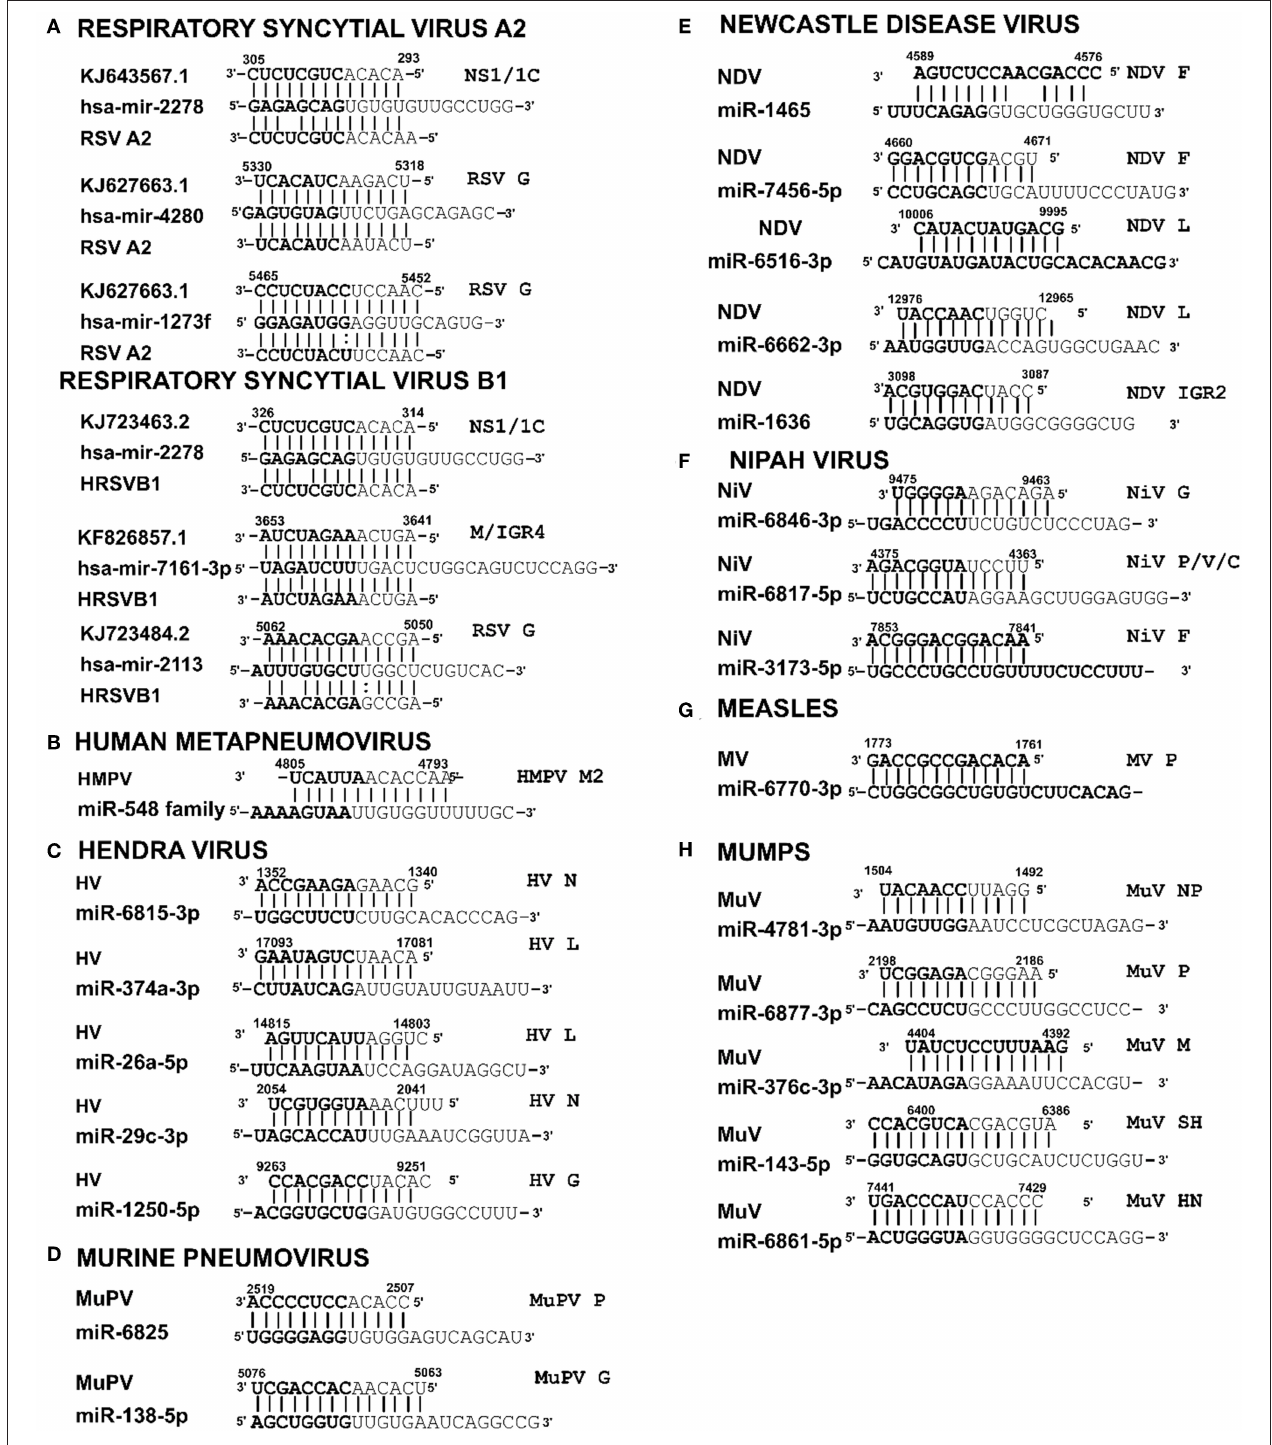
FIGURE 3 | Sequence alignments of miRNA vSSs encoded by different paramyxoviruses. Alignments show complementarity between host miRNA seed site and the corresponding vSS across Paramyxoviruses . Nucleotide numbers indicated viral genome coordinates while labels on the right indicate encoding viral gene. miRNA seed sequence is indicated in bold. Straight lines indicate Watson-Crick base pairing (AU/GC) while colon indicates a non-Watson-Crick base pair (GU).